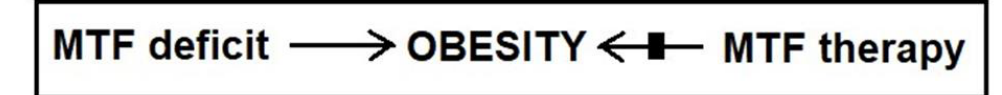
Figure 5. Schematic illustration depicting possible use of MTFs in the therapy of obesity that is currently viewed as an MTF-deficient disease.